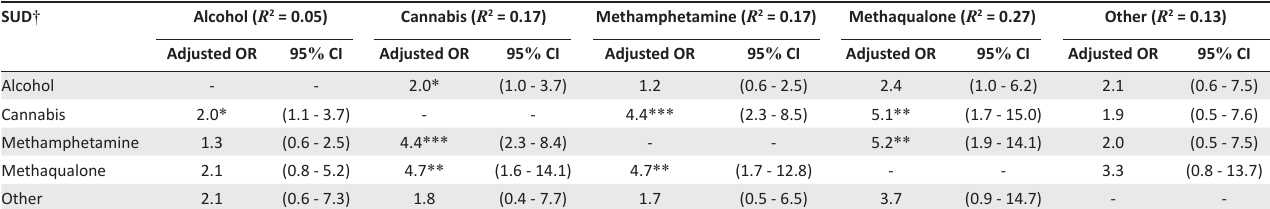
TABLE 3: Patterns and relationship between substance use disorders ( N =